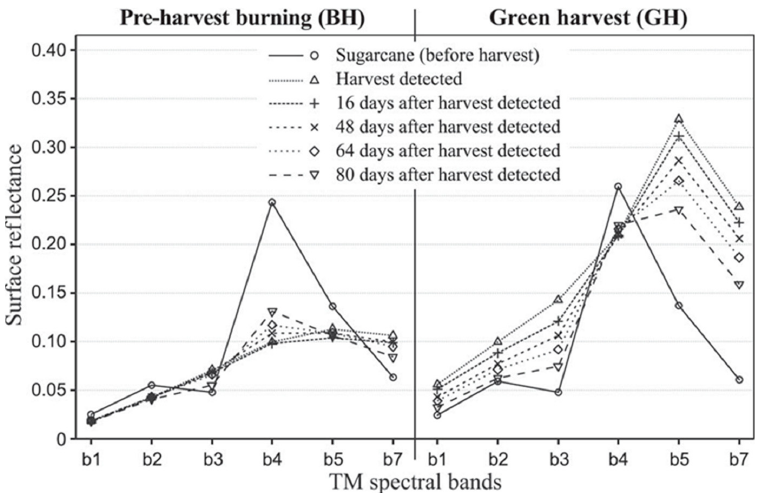
Figure 4. Dynamic spectro-temporal properties of burn harvest (left part of the figure) and green harvest (right part of the figure) in sugarcane fields. Obtained from Mello et al. [159].